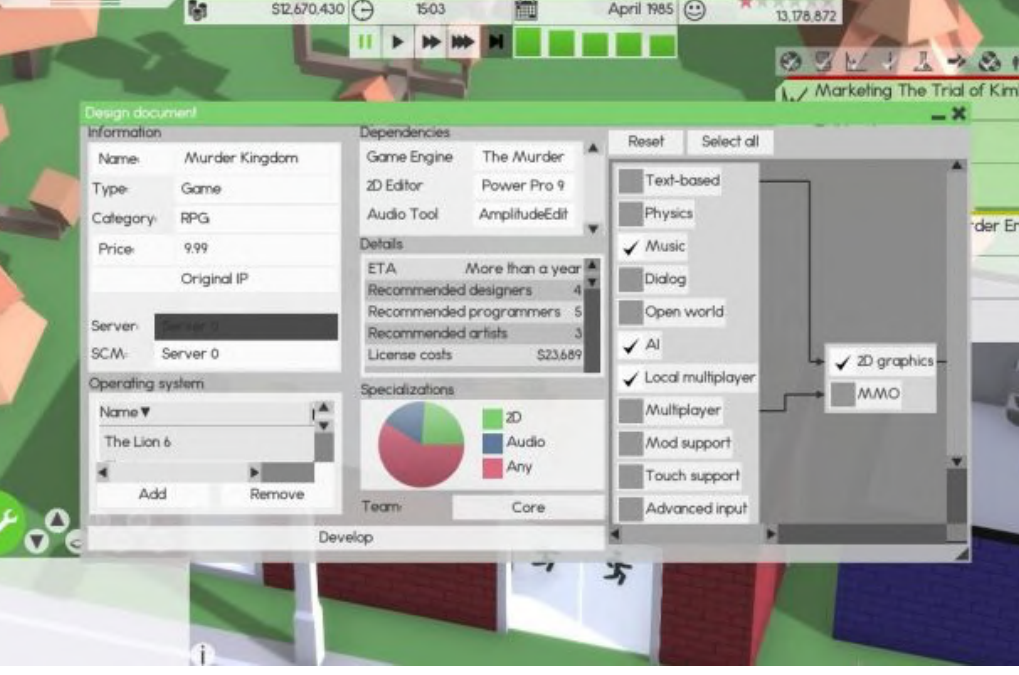
Figure 42: Presentation of paper